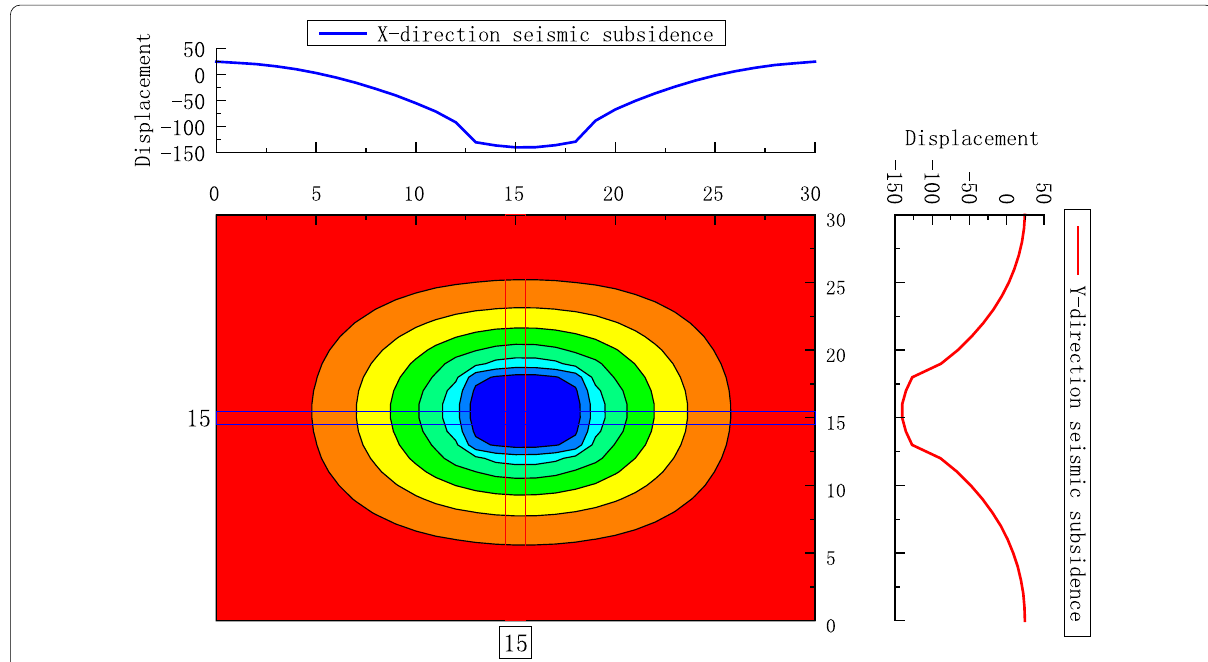
Fig. 16 Seismic subsidence of ground surface due to 0.30 g Kobe ground motion (cross-sectional view)